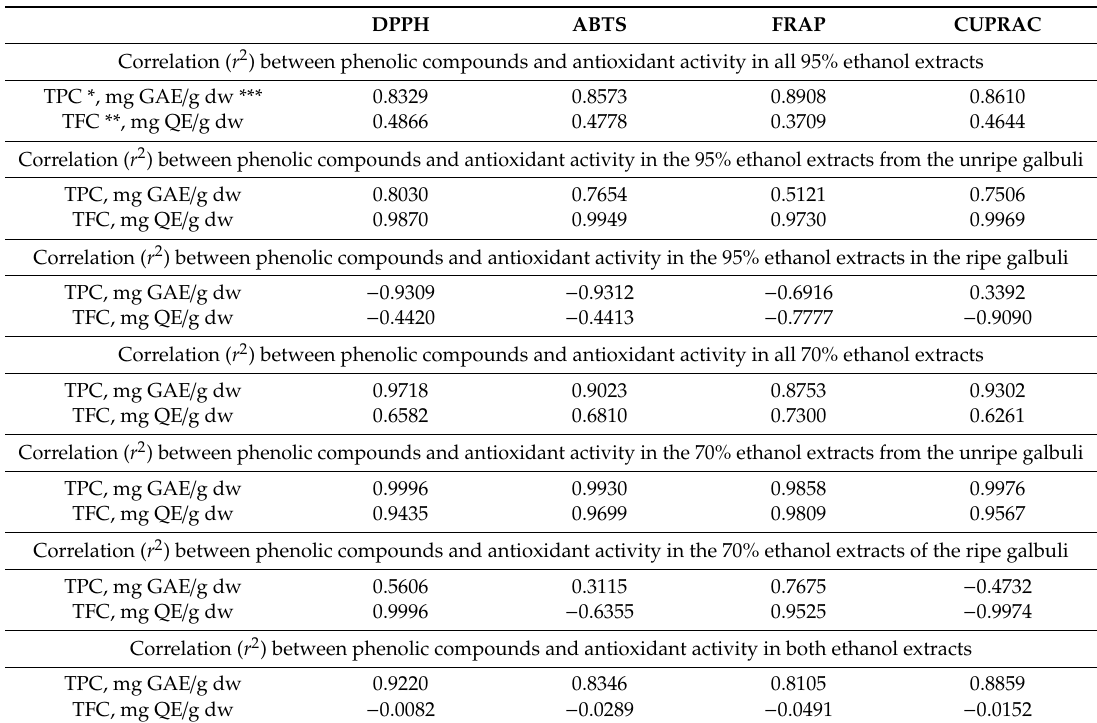
Table 7. Correlation ( r 2 ) between phenolic compounds and antioxidant activity of J. excelsa unripe and ripe galbuli from the di ff erent parts of Bulgaria. DPPH ABTS FRAP